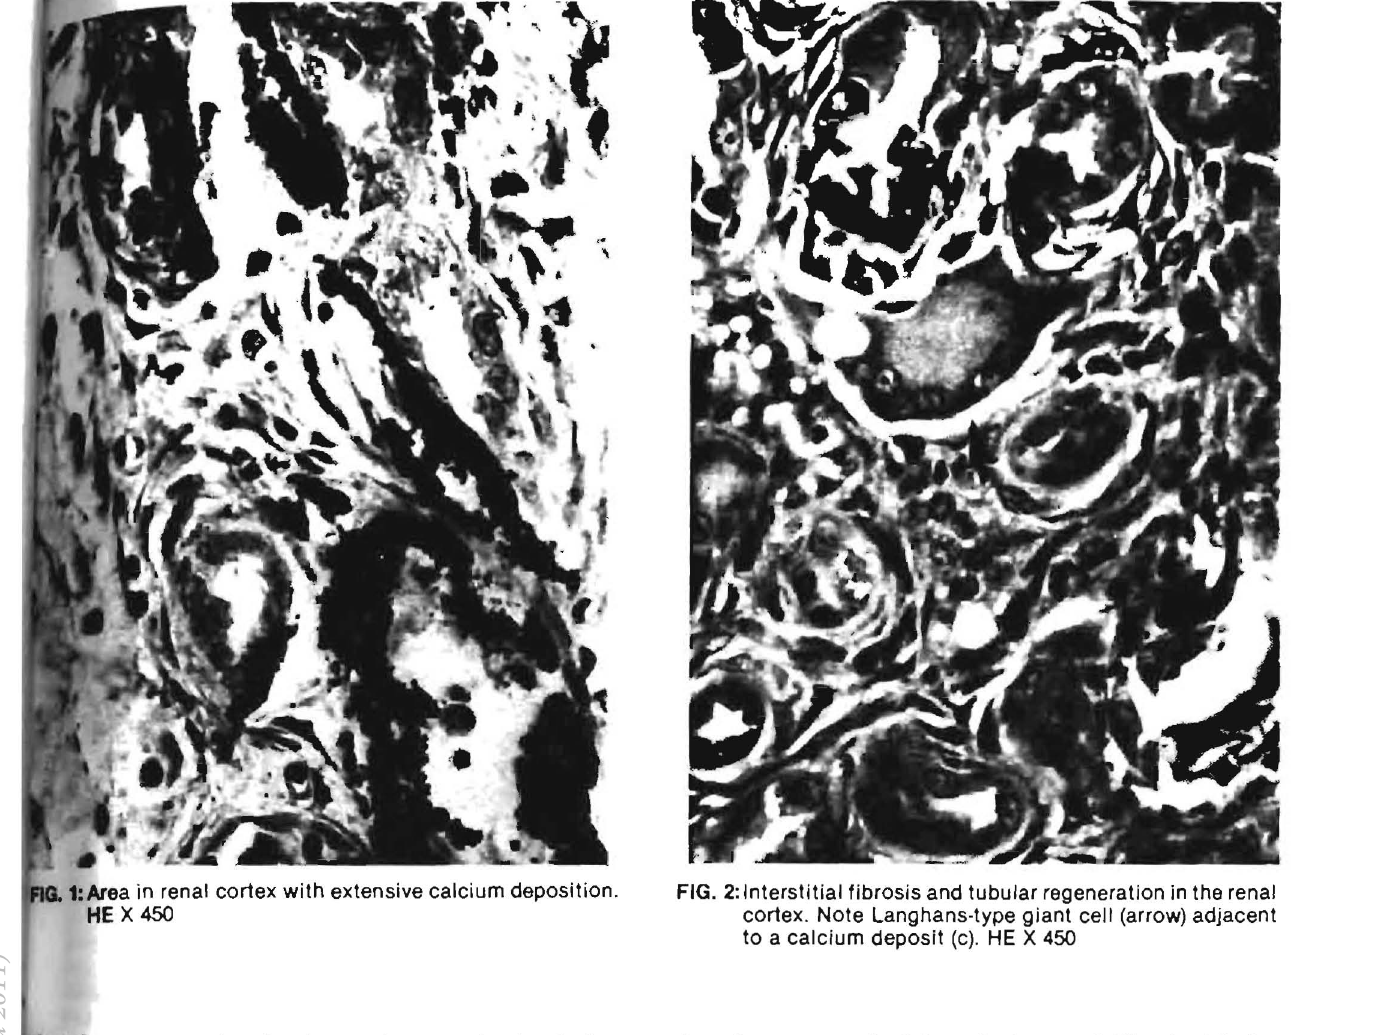
FIG. 2: Interstitial fibrosis and tubular regeneration in the renal cortex. Note Langhans-type giant cell (arrow) adjacent to a calcium deposit (c). HE X